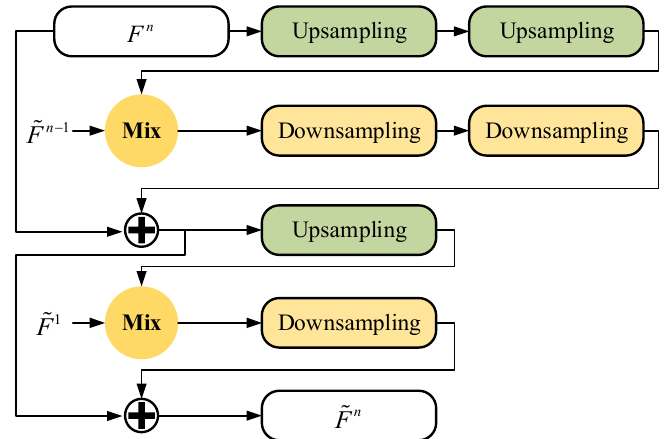
Figure 3. Architecture of Adaptive Feature Fusion module.